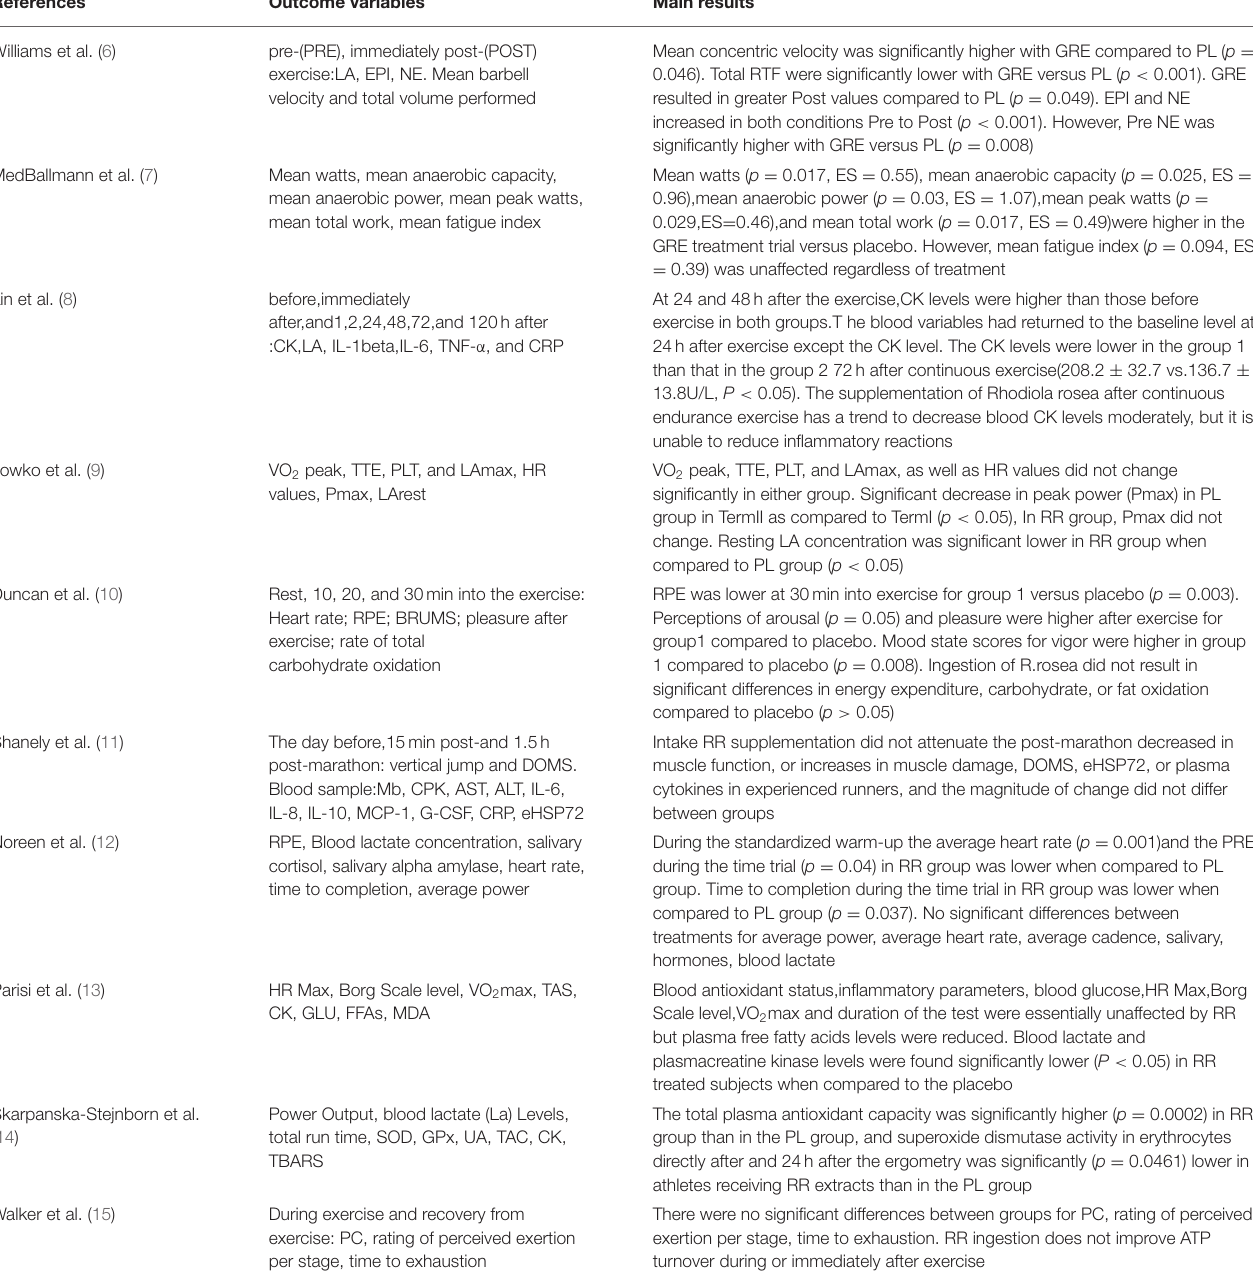
TABLE 2 | Outcome variables and main